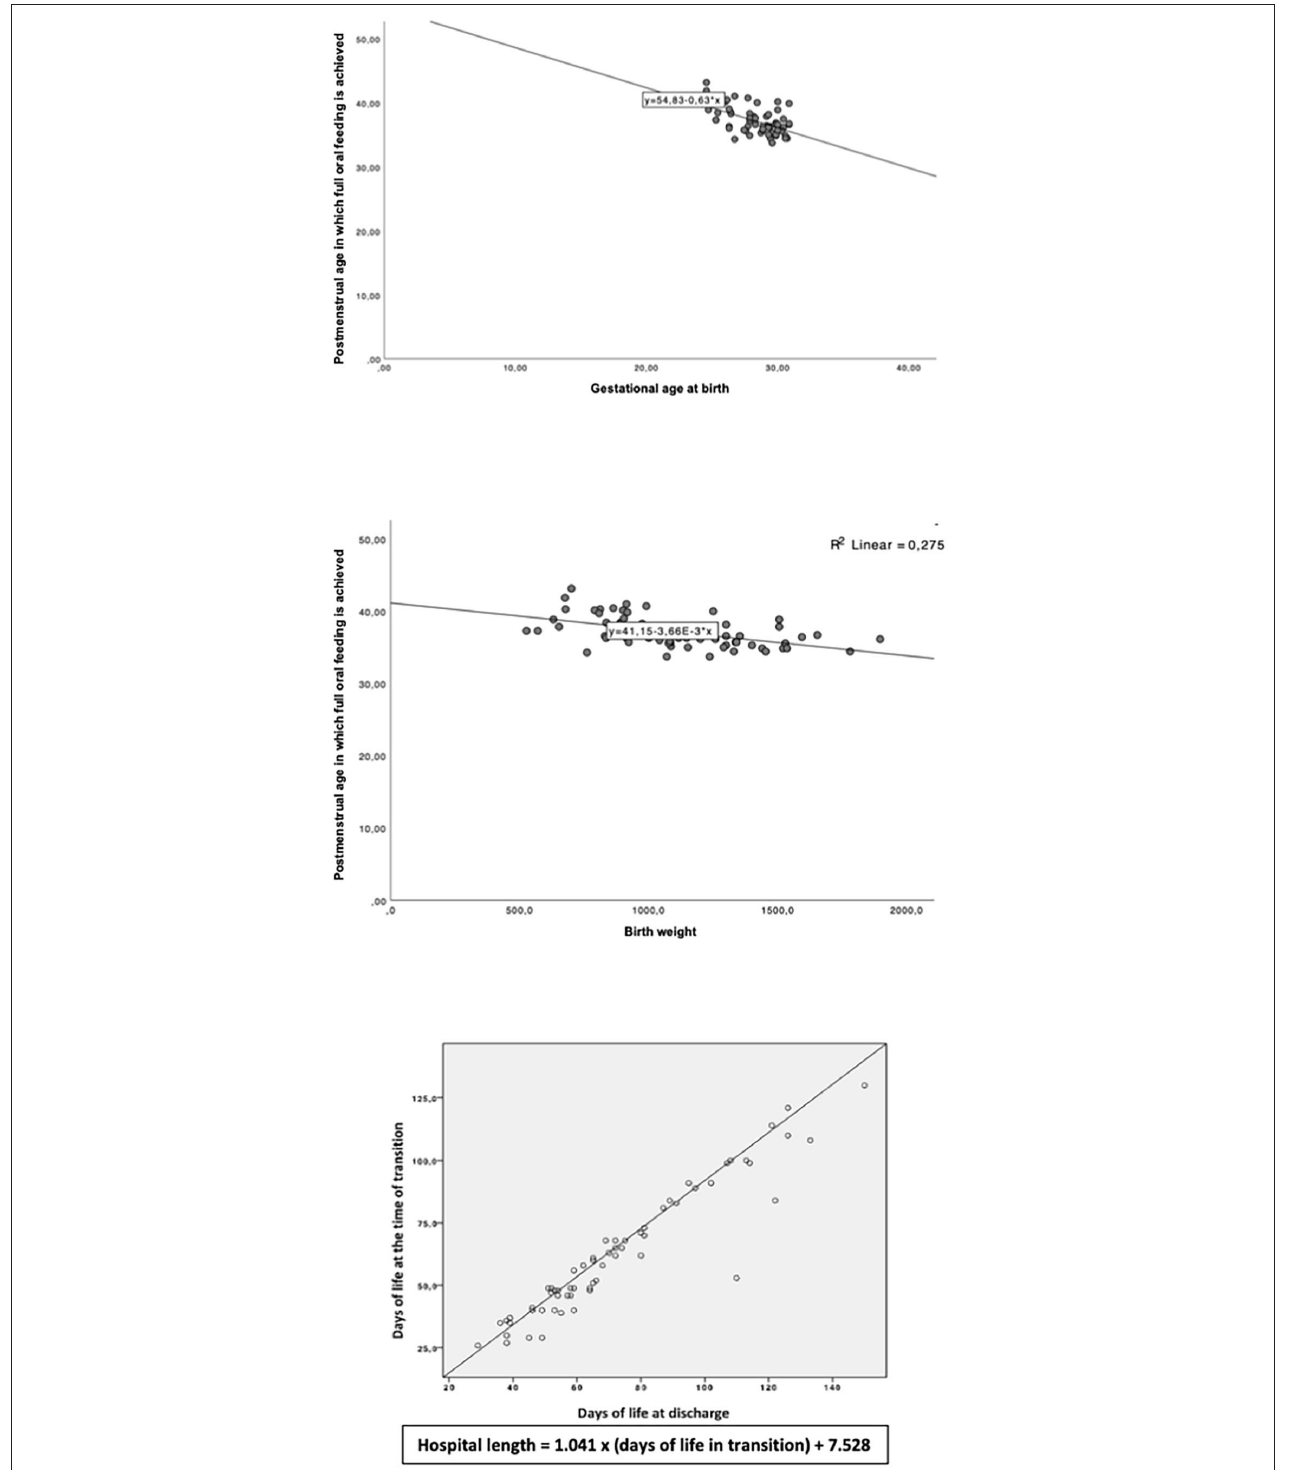
FIGURE 2 | Relationship between gestational age at birth and postmenstrual age at which full oral feeding was achieved; Relationship between birth weight and postmenstrual age at which full oral feeding was achieved; relationship between age at discharge and age at full oral feeding.